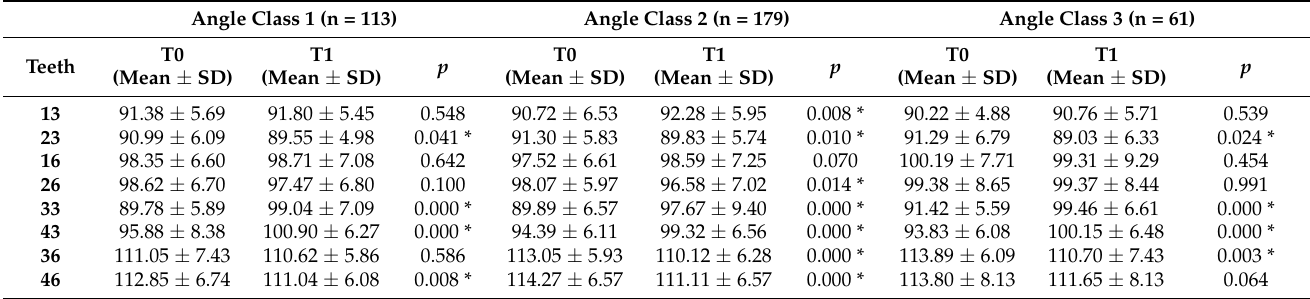
Table 7. Results of T0/T1 angulation changes for angle classifications.